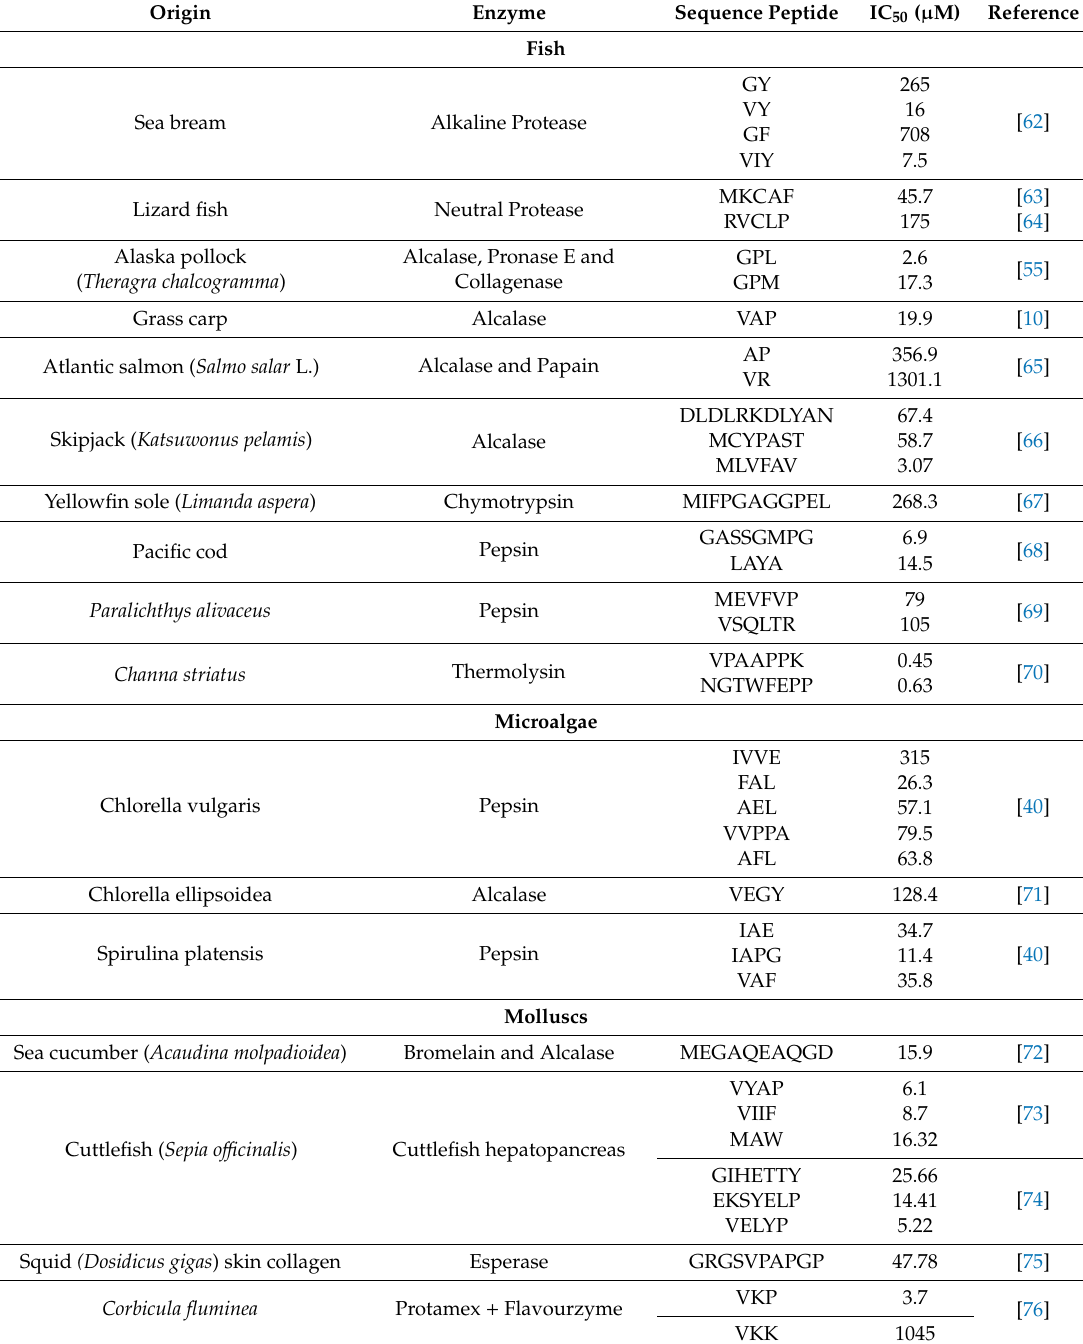
Table 1. List of identified peptides derived from marine resources; origin, sequence peptides, and IC 50